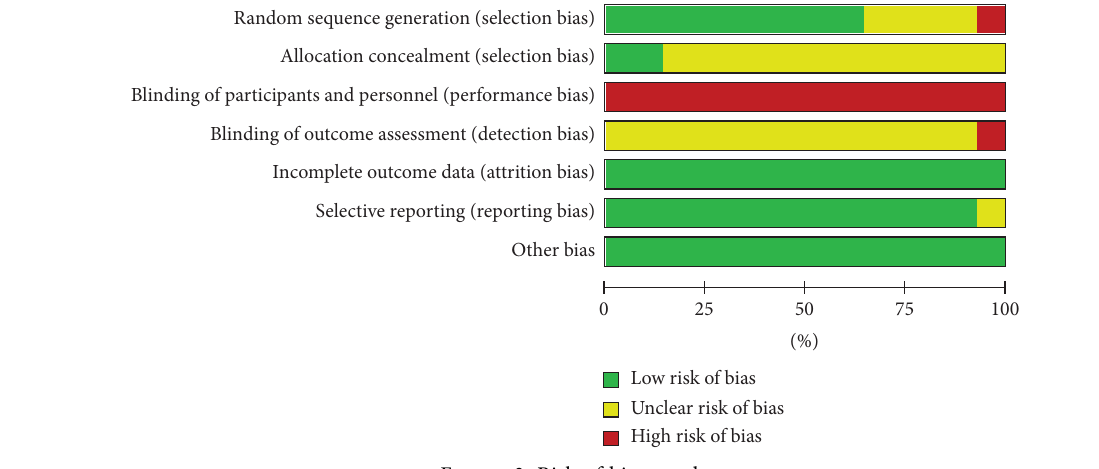
Figure 3: Risk of bias graph.